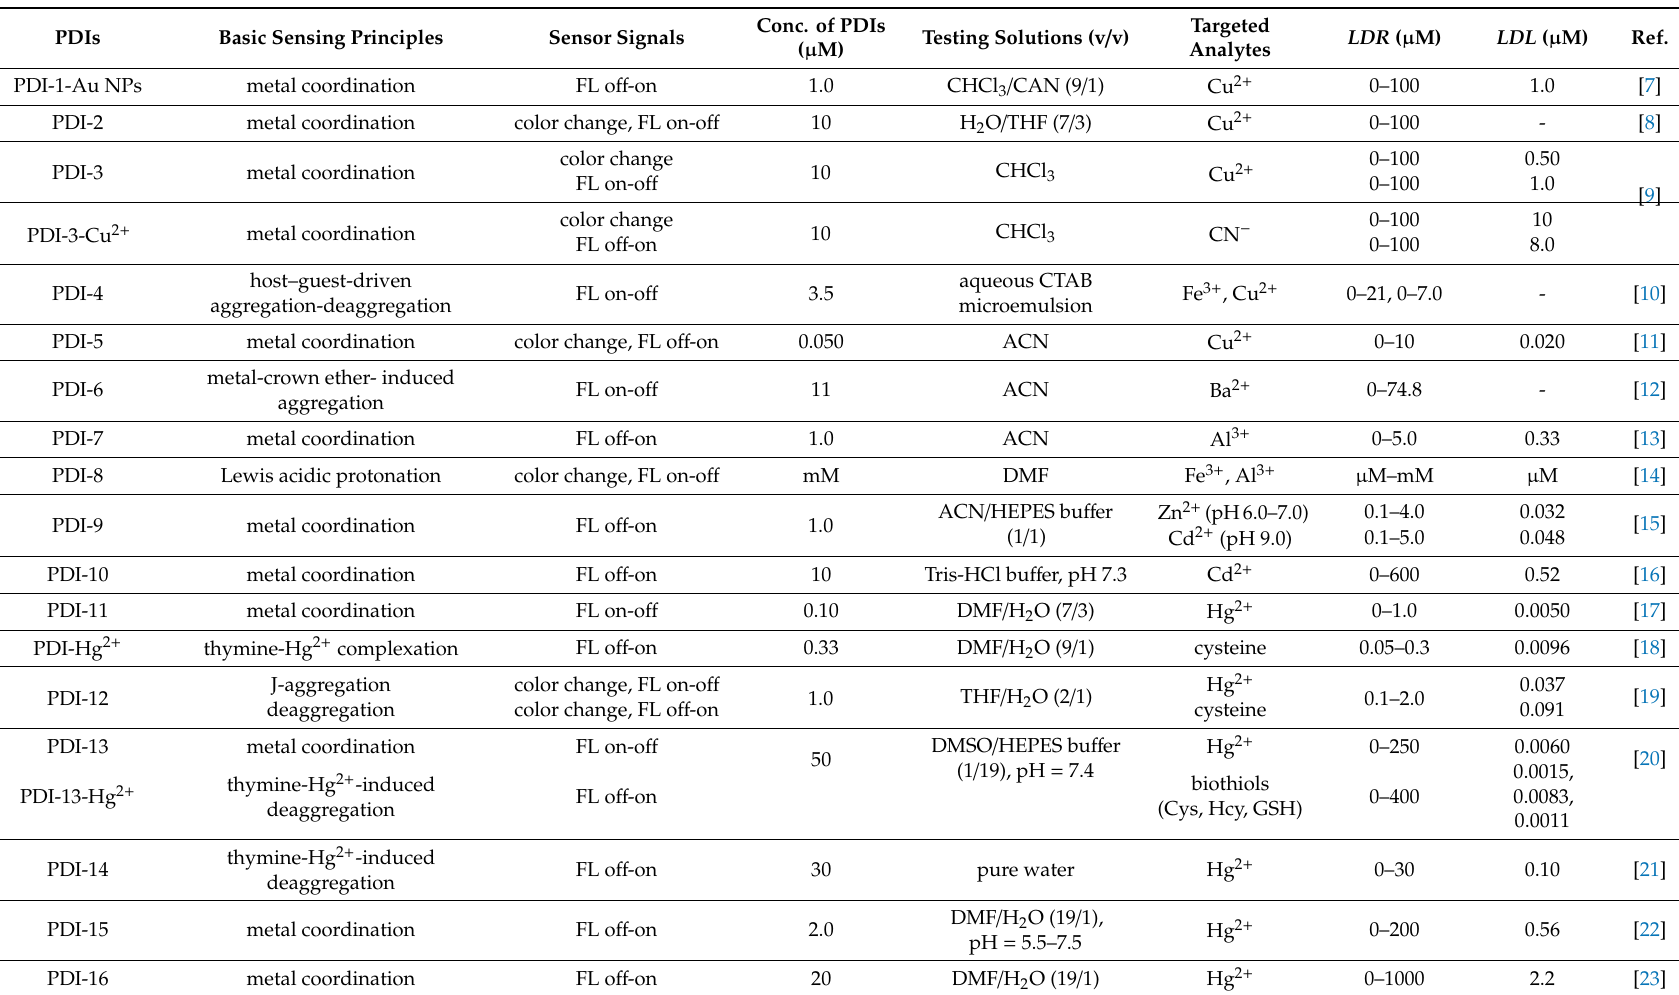
Table 1. Sensor performance of PDI-based optical chemosensors toward diverse analytes under optimized testing conditions and related sensing principles 1